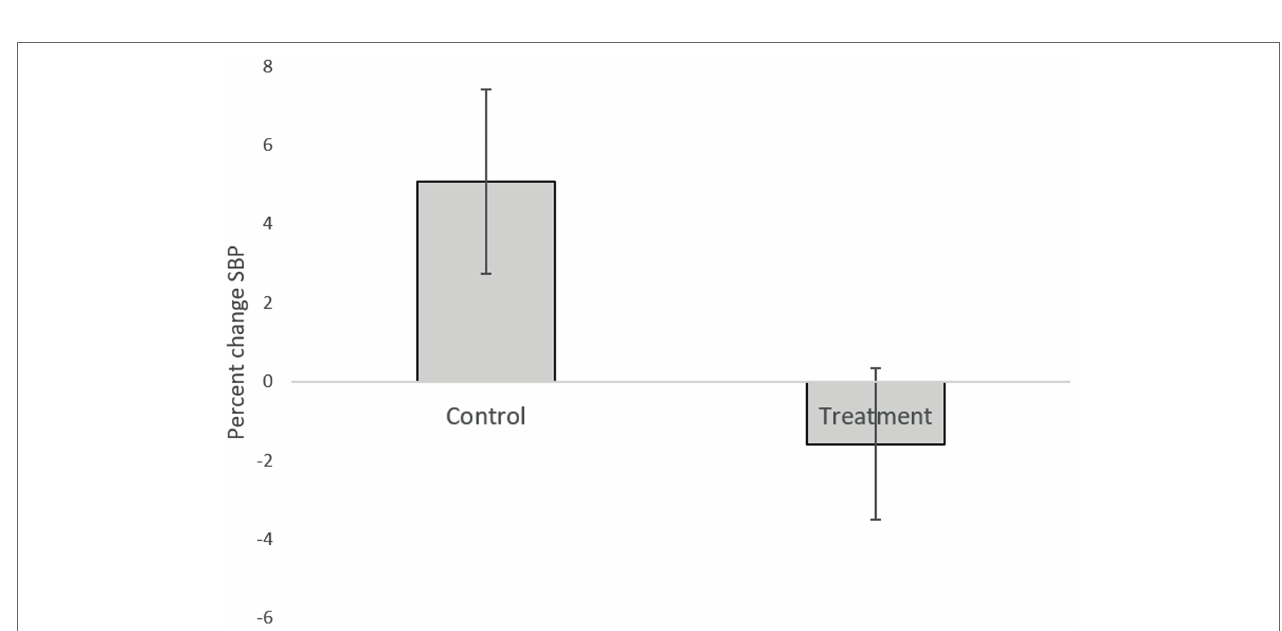
FIGURE 4 | Systolic blood pressure difference between the two lab visits in both the treatment and control